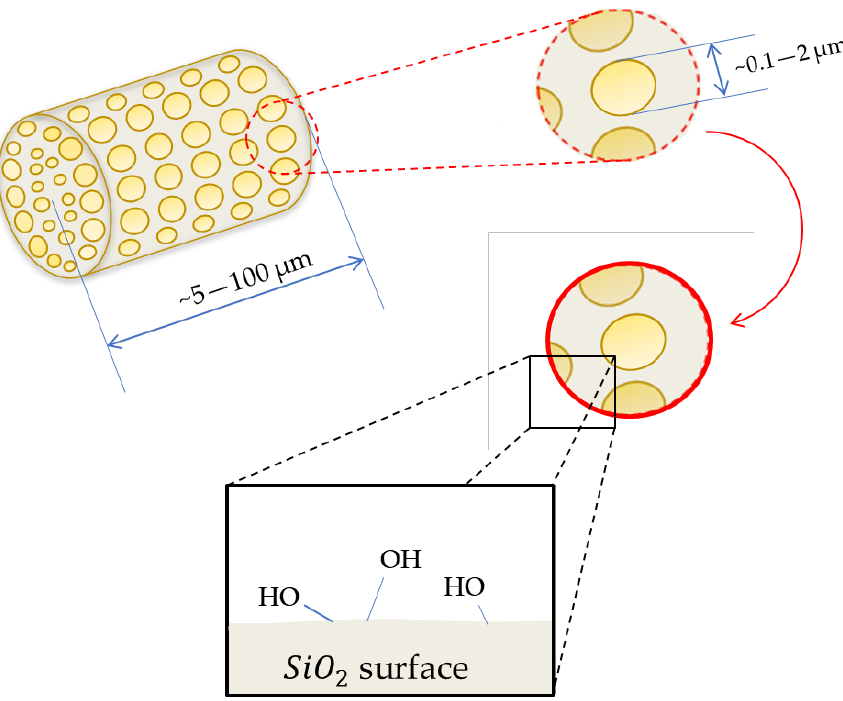
Figure 1. Diagram representing diatomaceous earth microstructure and surface chemistry.